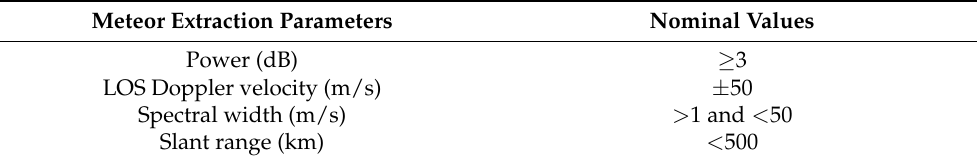
Table 3. The characteristic values of meteor echo as extracted by the traditional